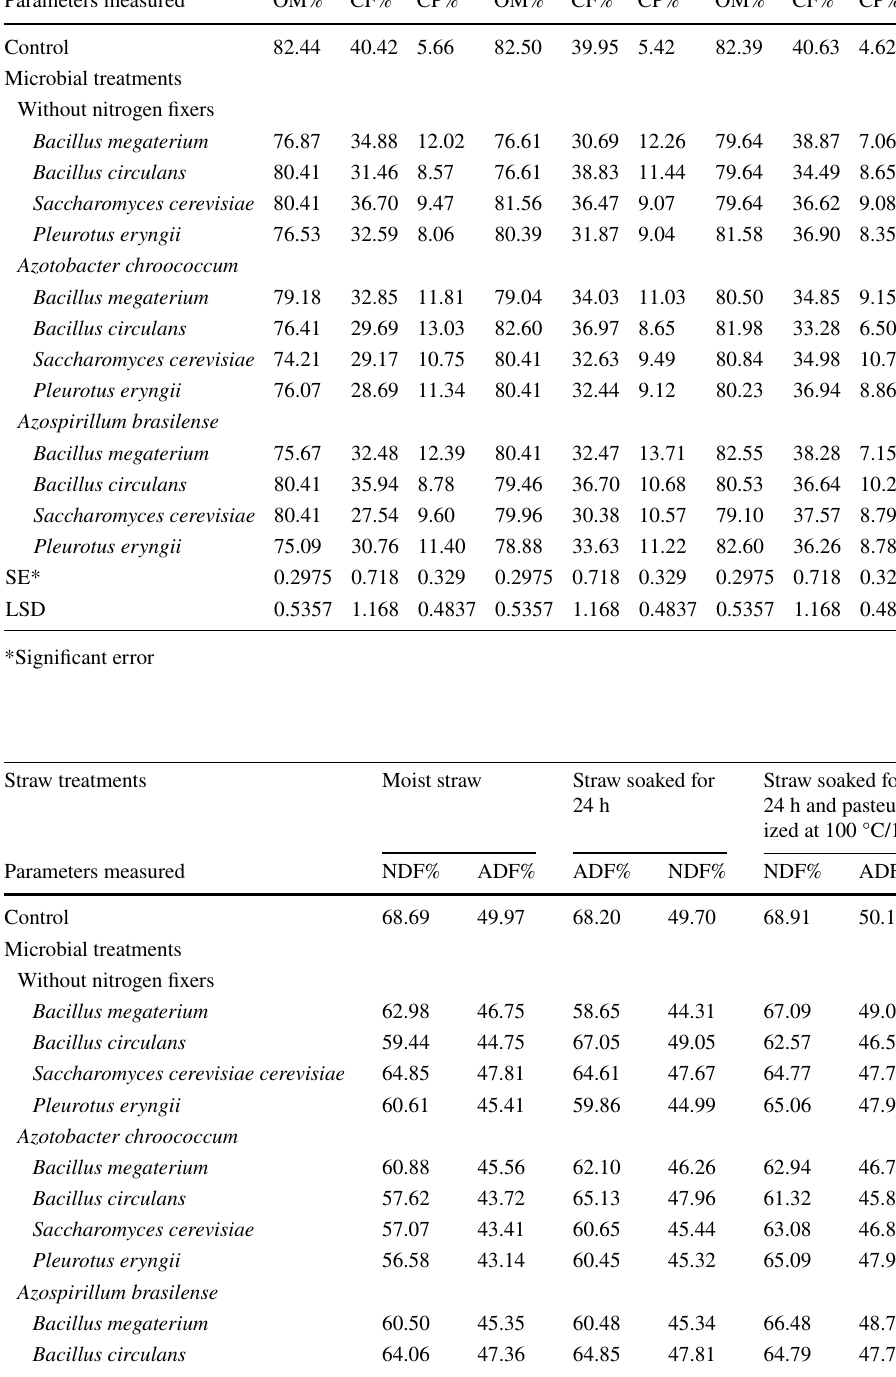
Table 2 Nutritional values of rice straw (OM, CF, and CP%), affected by combined interactions between different microbial inoculants and some physical treatments